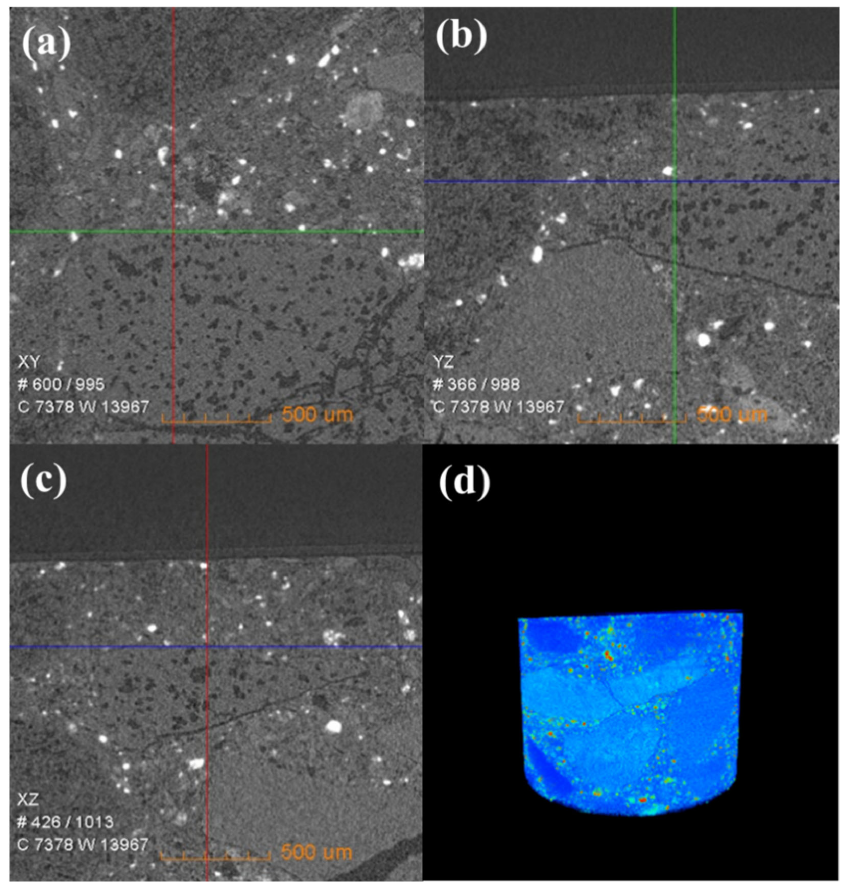
Figure 6. X ‐ ray CT of a new saggar sample. ( a ), ( b ), and ( c ) Internal X ‐ ray CT images of a new saggar Figure 6. X-ray CT of a new saggar sample. ( a ), ( b ), and ( c ) Internal X-ray CT images of a new saggar sample scanned from the XY, YZ, and XZ directions, respectively. ( d ) Three ‐ dimensional image in sample scanned from the XY, YZ, and XZ directions, respectively. ( d ) Three-dimensional image in which bright and dark colors represent high and low density, respectively. which bright and dark colors represent high and low density,